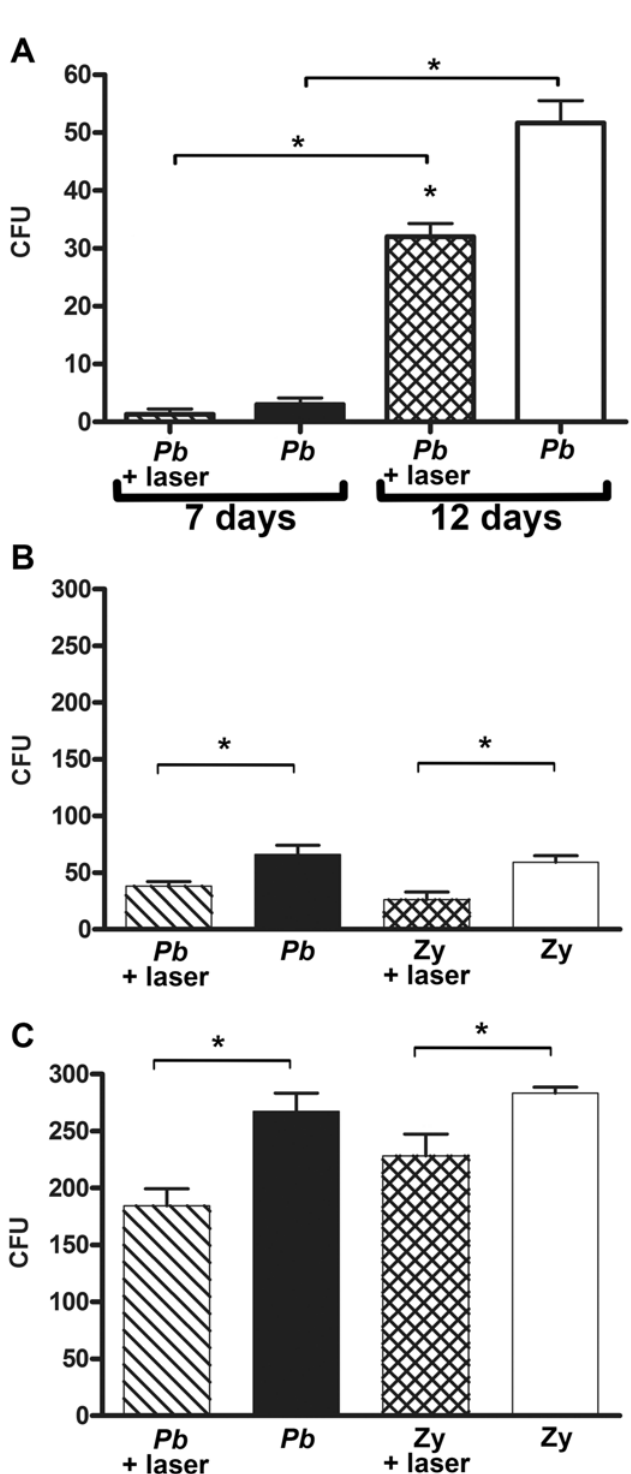
Fig 7. Fungicidal capacity of PMN. A — Colony forming units (CFU) of Pb at 7 and 12 days evaluation for non-irradiated and irradiated PMN. p = 0.0002 ( * ) between non-irradiated and irradiated PMN after 12 days of fungal growth; p = 0.0118 ( * ) between the irradiated groups at 7 and 12 days of fungal growth and p = 0.0003 ( * ) between the non-irradiated groups at 7 and 12 days of fungal growth. The colony forming units of Pb after co-cultivation with PMN recruited by Pb infection or Zy inoculation are shown after: B — 7 days: p = 0.0369 ( *